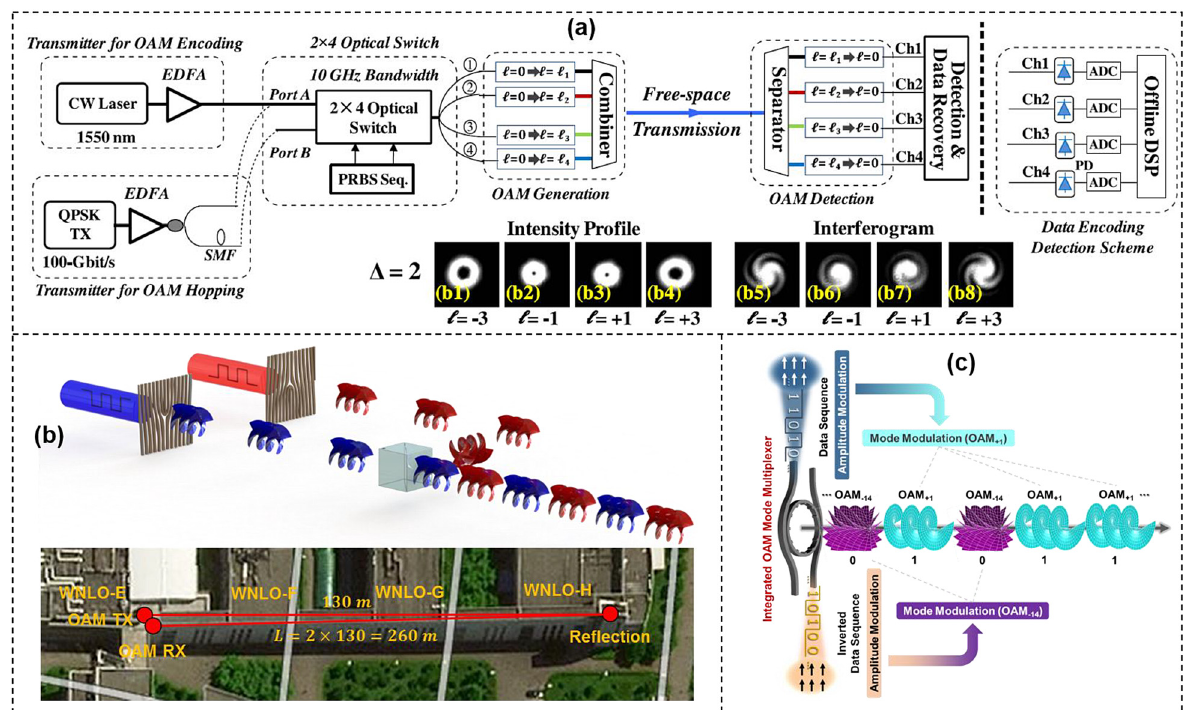
Figure 6: High-speed OAM modulation communications. (a)OAM-baseddataencodingandhoppingsystems[70].(b)Conceptandprincipleofhigh-speedOAMmodulationandlayoutofa260-m25-Gbit/s OAMmodulationdatatransmissionlinkbetweenWNLO-EbuildingandWNLO-Hbuilding.WNLO:WuhanNationalLaboratoryforOptoelectronics.(c) Concept and principle of high-speed photon dimension mapping (amplitude-to-OAM modulation mapping) for OAM modulation assisted by an integrated OAM beam multiplexer. Reprint permission obtained from